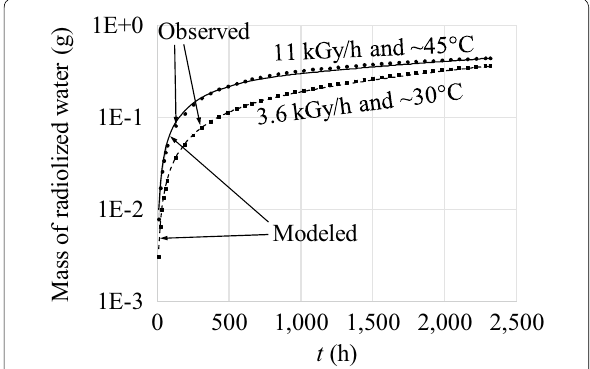
Fig. 7 Mass of radiolyzed water (estimated as 9-times the mass of evolved H 2 ) vs. time for unconditioned cement paste specimens exposed to different irradiation dose rates and temperatures, as observed by Kontani et al. (2010) or modeled according to (18), (24), and